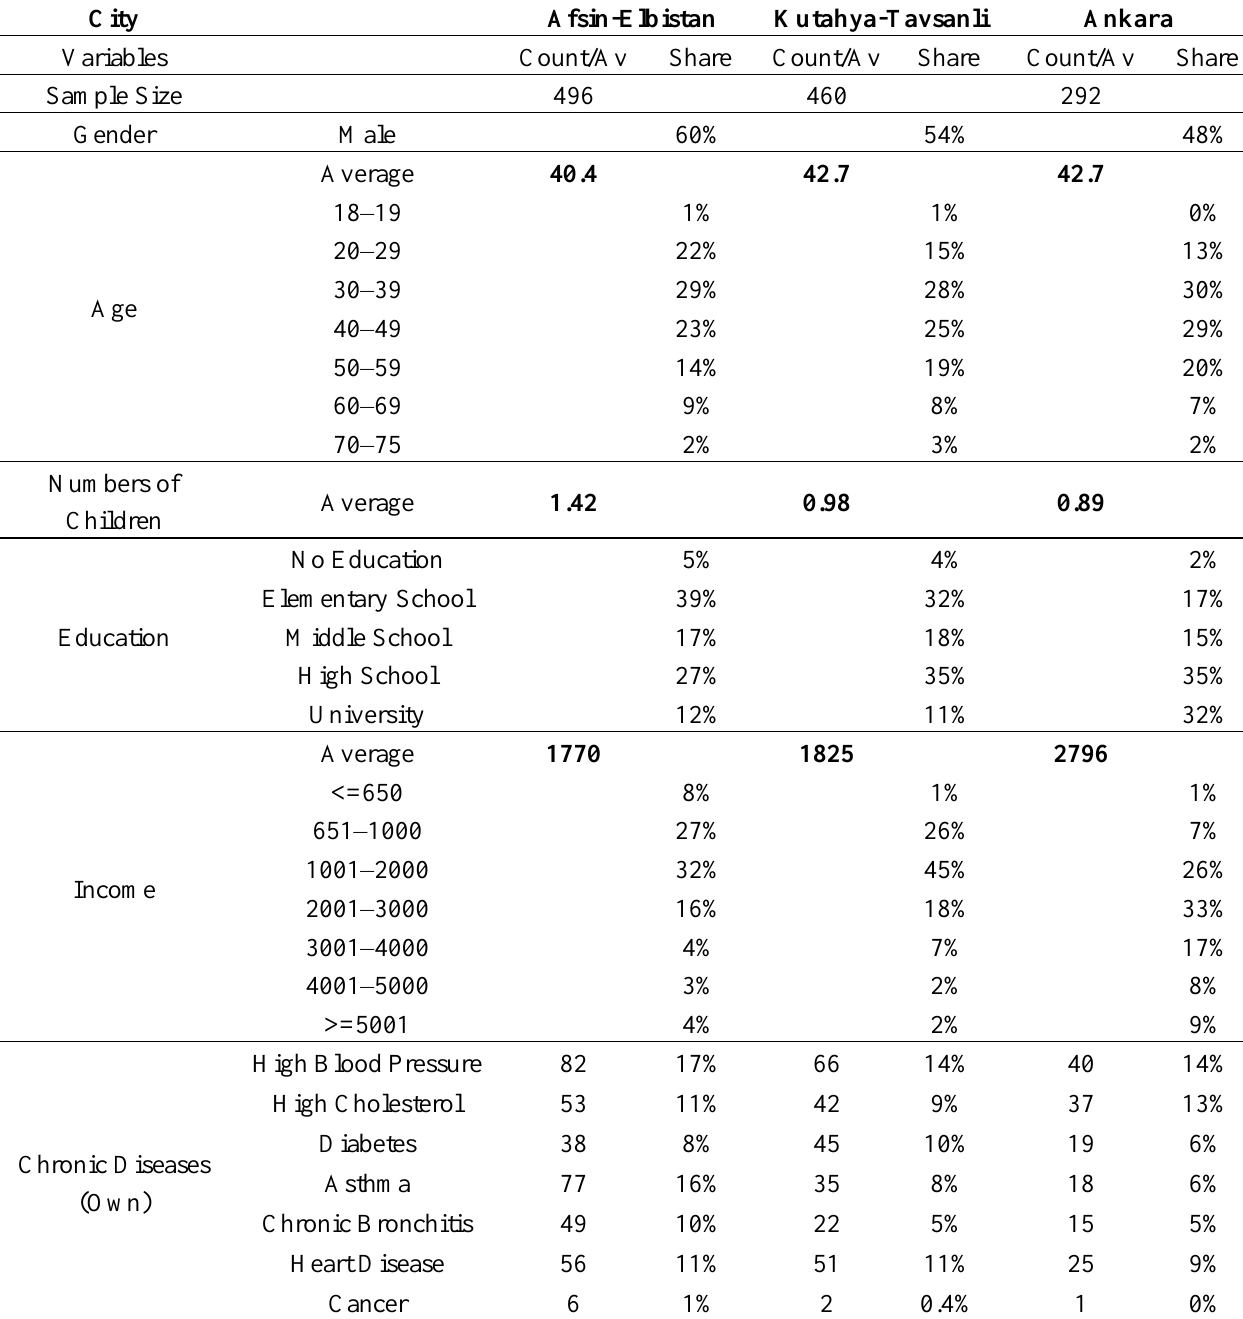
Table 2. Descriptive Statistics for Socio-Demographic